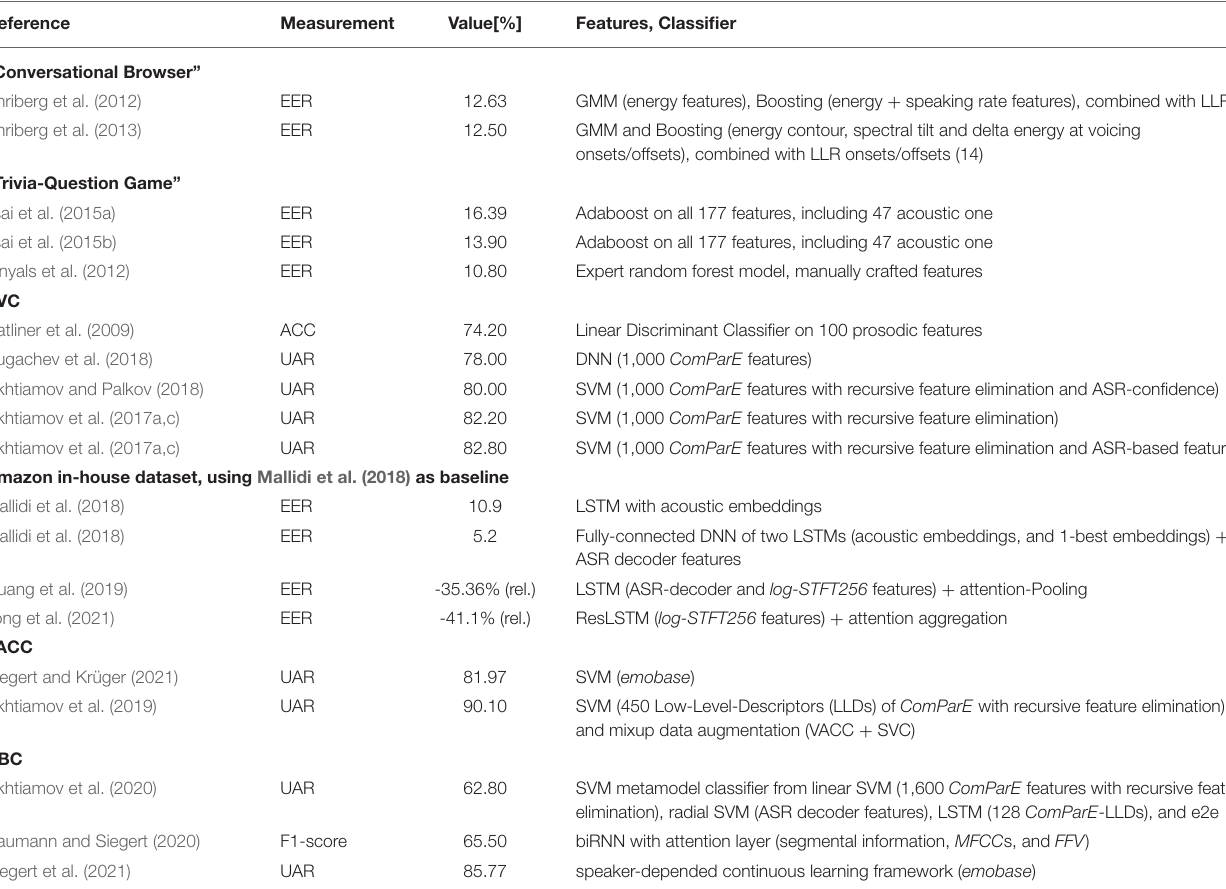
TABLE 5 | Comparison of DD/HD recognition performance of selected identified studies, compiled regarding the utilize